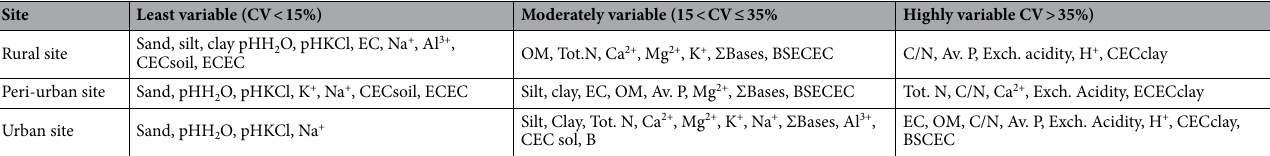
Table 7. Variability classes of soil properties for the different sites in Bamenda municipality.